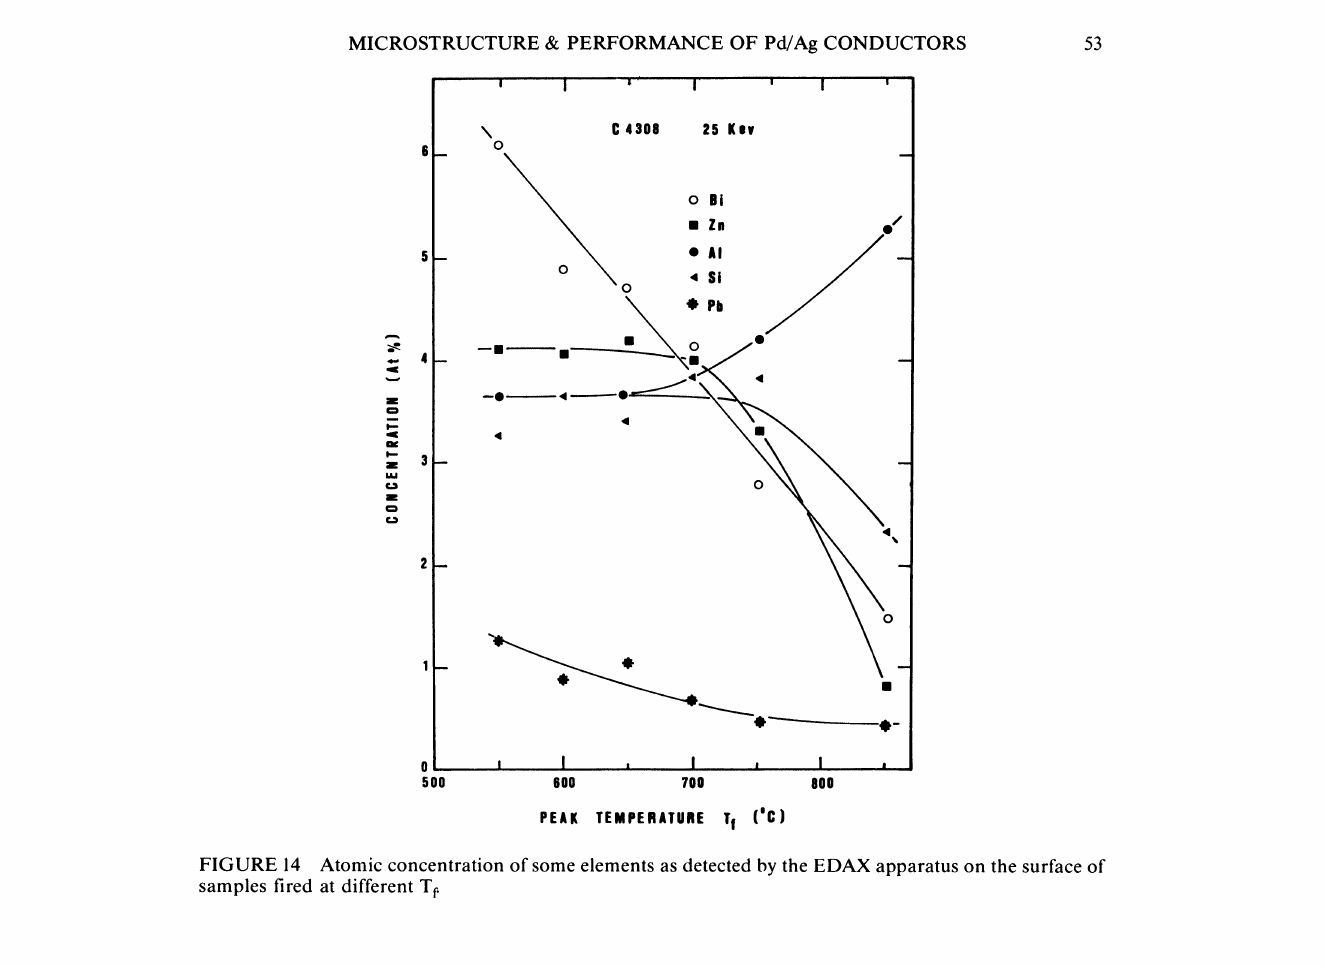
FIGURE 14 Atomic concentration of some elements as detected by the EDAX apparatus on the surface of samples fired at different